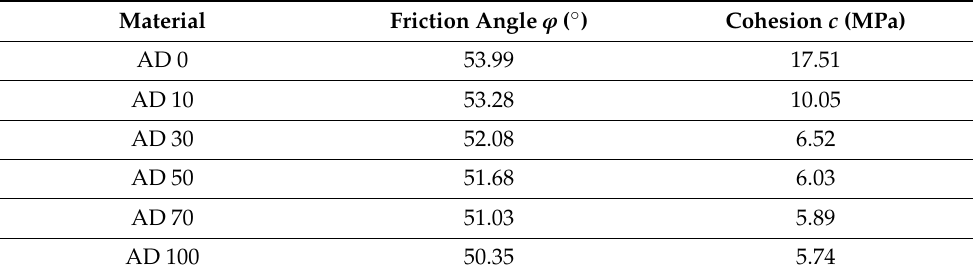
Table 4. Shear strength parameters of the Mohr-Coulomb failure